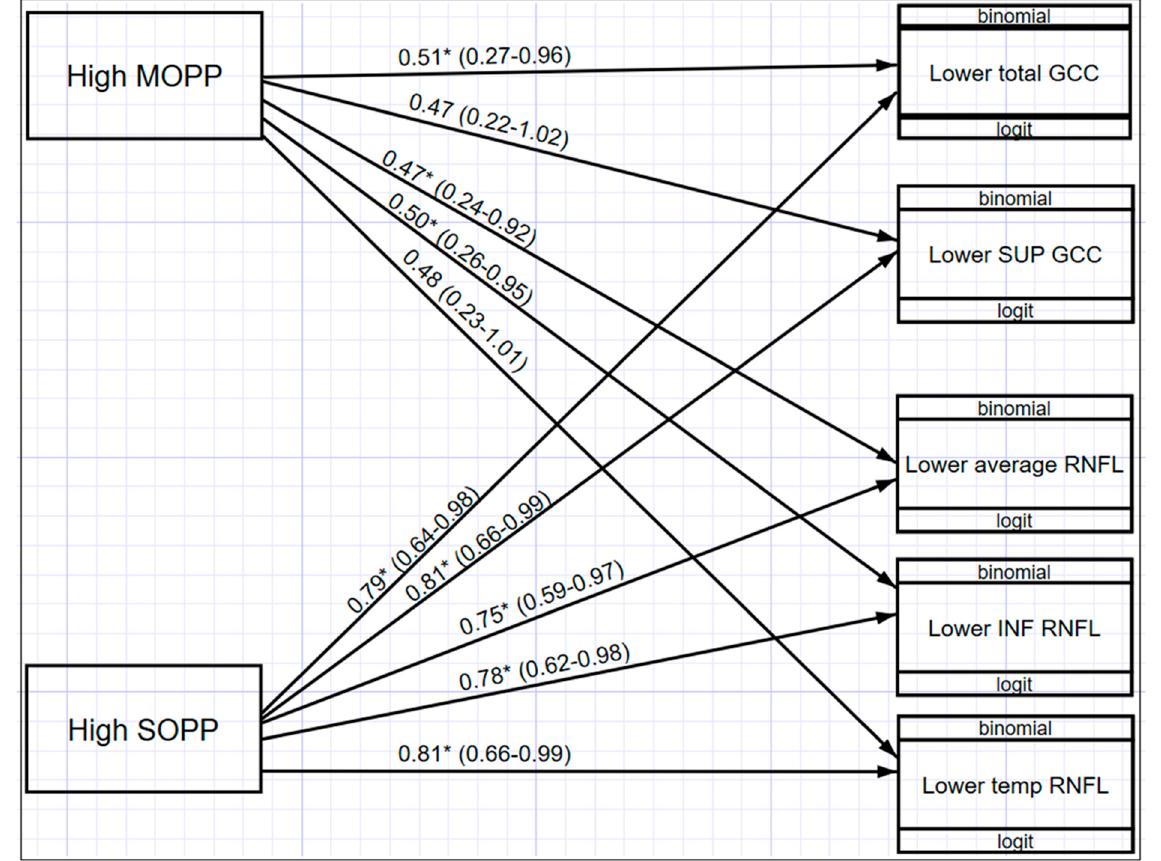
Figure 6. Structural equation model (SEM) with the relationships between OPP and GCC and ONH-RNFL * ( p < 0.05).